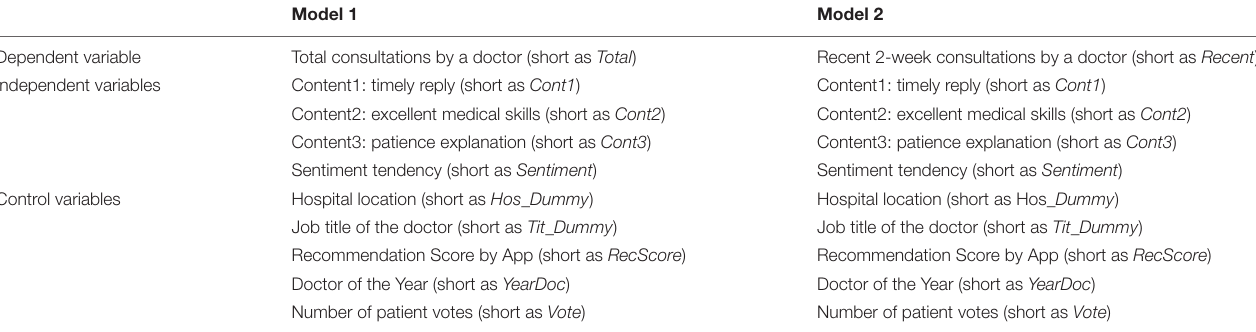
TABLE 6 | The explanation of econometric model 1 and model 2. Model 1 Model 2